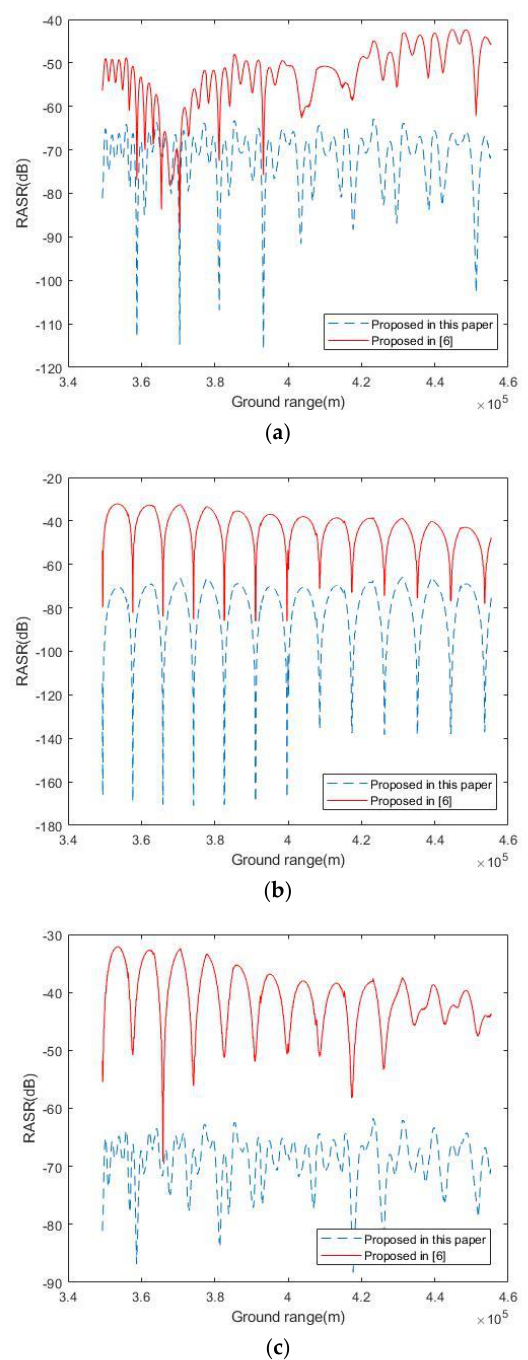
Figure 14. Computed range-ambiguity-to-signal ratio (RASR) over the whole swath: ( a ) conventional RASR part. ( b ) RASR caused by the OFDM demodulation. ( c ) the final RASR. The antenna elevation pattern was tapered by a Dolph–Chebyshev window for a sidelobe level of −35 dB.